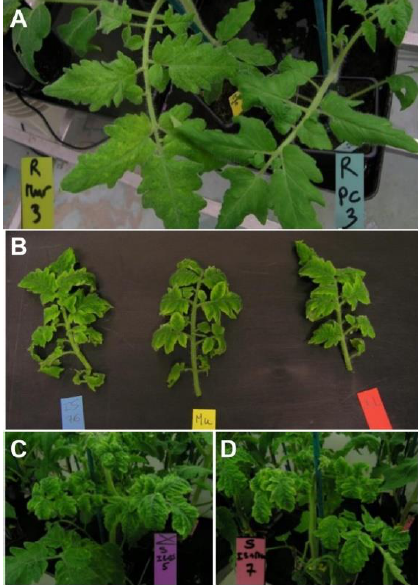
Figure 6. ( A ) Slight yellow mosaic in Pristyla tomato plants (resistant, Ty-1) agroinoculated with pTYLCV-Mu15 ( left ) compared with same plants inoculated with empty vector ( right ) at 18 days post inoculation (dpi). ( B – D ) Symptom expression in susceptible plants at 30 dpi; ( B ) comparison between clones in single infection, from left to right: TYLCV-IS76; TYLCV-Mu15, and TYLCV-IL; ( C , D ) susceptible plants mixed inoculated with TYLCV-IL + TYLCV-IS76 and pTYLCV-Mu15 + TYLCV-IS76, respectively.